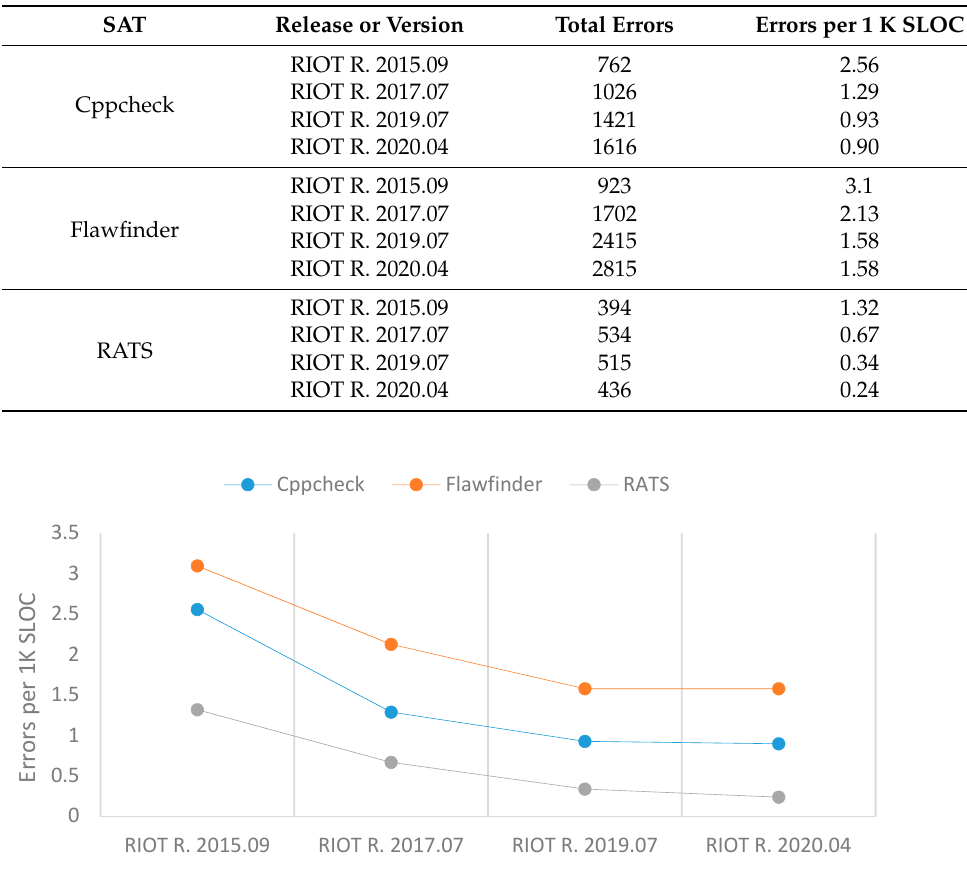
Figure 4. Errors per 1K SLOC of RIOT.